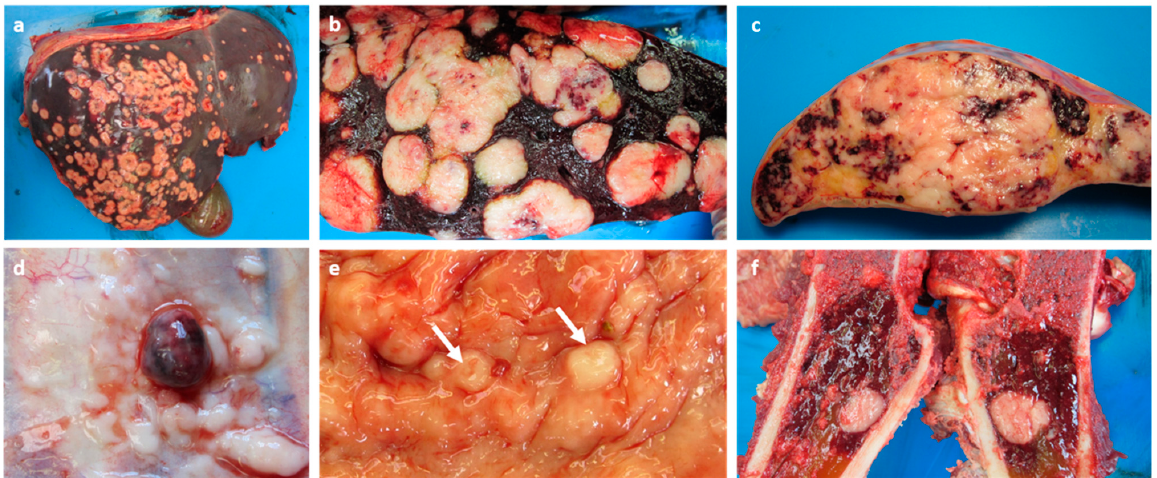
Figure 1. Macrosopic photos of the neoplastic masses present in the organs of the sable antelope at necropsy. ( a ) Liver with multifocal-to-coalescing, firm, white-to-cream-coloured hepatic metastatic nodules with some central areas of necrosis present. The right and quadrate lobes appeared to be the worst affected parts. Cut surface of the liver ( b ) and spleen ( c ) showing multifocal-to-coalescing, firm, white-to-cream-coloured splenic metastatic nodules (with some areas of necrosis) invading the parenchyma. ( d ) A small well-demarcated red nodule surrounded by white proliferative tissue on the parietal pleural surface of the left-side of the mid-thoracic cavity. ( e ) A few firm, well-demarcated, white-to-cream-coloured nodules (arrows) in the uterine body. ( f ) Cut surface of the femur with one solitary white-to-cream-coloured nodule present in the proximal end of the red marrow.